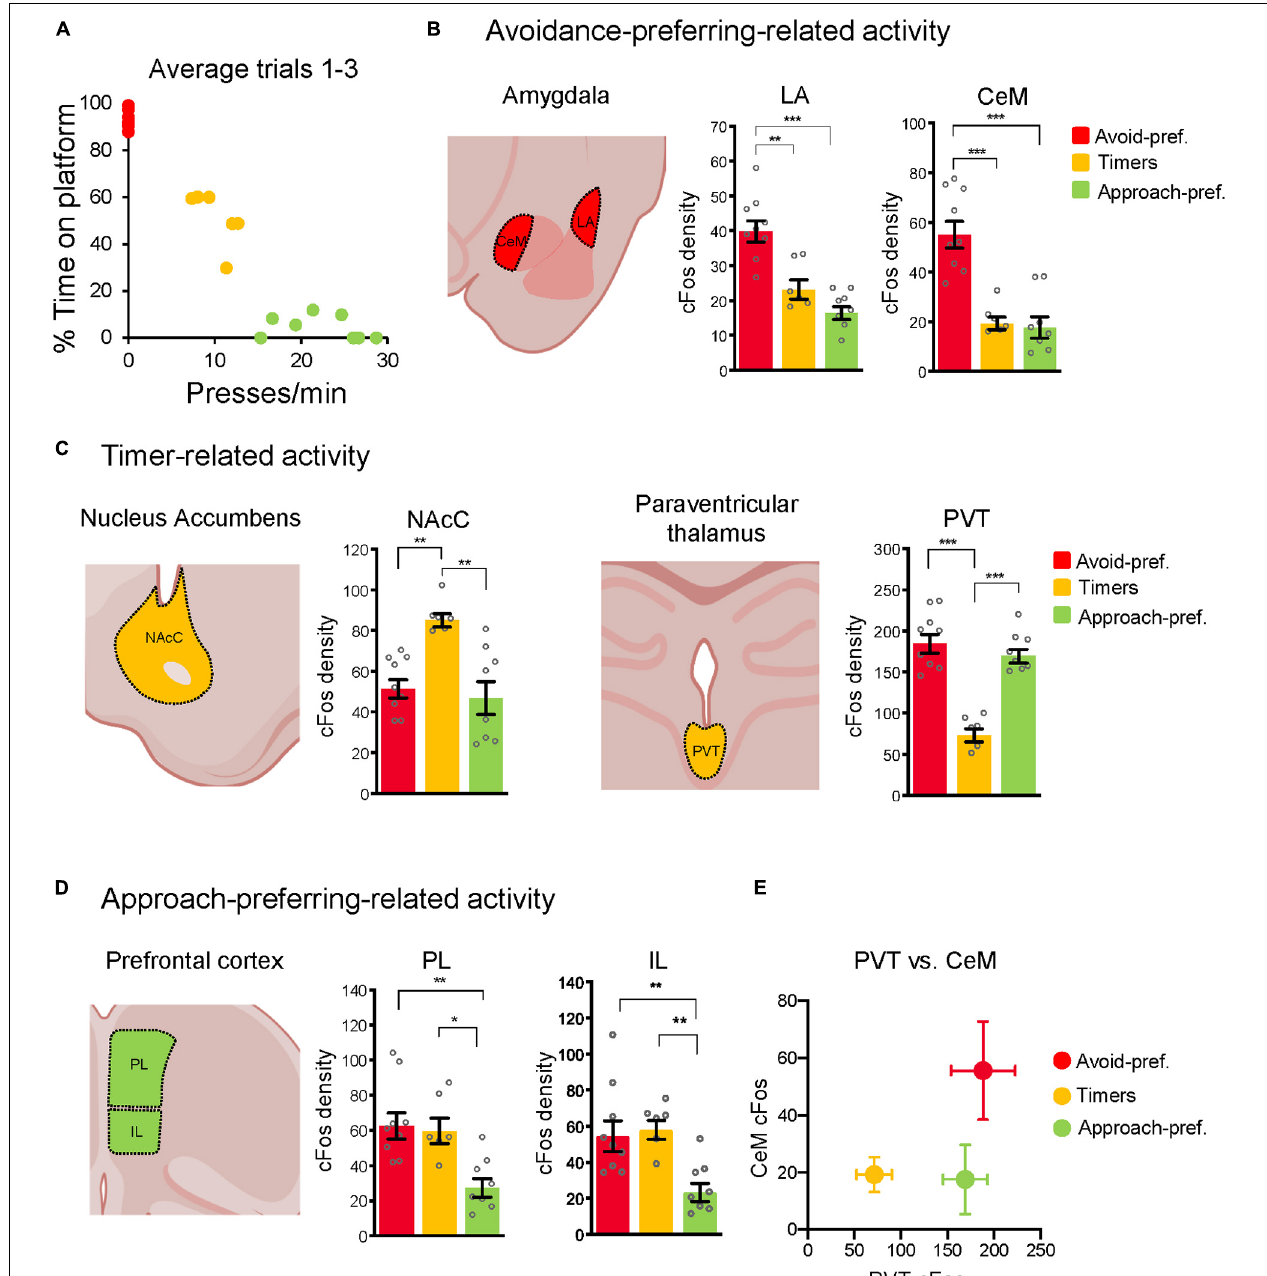
FIGURE 4 | The three subgroups showed distinct neuronal activity patterns. (A) Average presses/min vs. % time on platform for the three trials at conflict test in rats included in the cFos analysis. Only rats with consistent subgroup behavior were selected for cFos analysis. (B) Rats were euthanized 90 min after the conflict test and processed for cFos. Avoid-pref. Rats showed elevated activity in the lateral (LA) and centromedial (CeM) subregions of amygdala, relative to the other two subgroups. (C) Timer rats showed elevated activity in the nucleus accumbens-core (NAcC), and reduced activity in the paraventricularthalamus (PVT), relative to the other two groups. (D) Approach-pref. rats showed reduced activity in the prelimbic (PL) and infralimbic (IL) subregions of medial prefrontal cortex, relative to the other two subgroups (one-way ANOVA* p < 0.05, ** p < 0.01, *** p < 0.001 Tukey post-hoc test). (E) Activity within CeM and PVT separated the three subgroups, consistent with low levels of fear and high levels of behavioral flexibility in Timer rats.